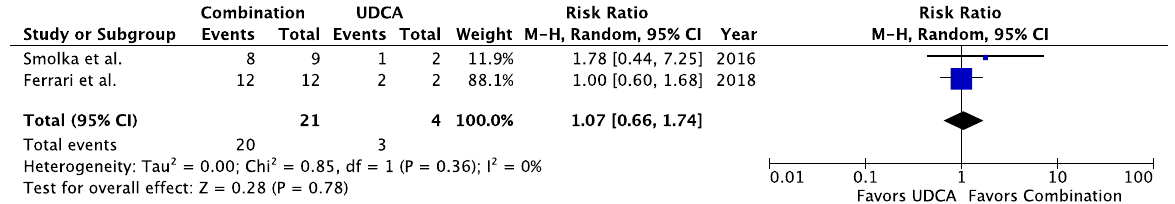
Figure 10. Biochemical improvement in ASC patients treated with combination therapy vs. UDCA. UDCA = ursodeoxycholic acid and Combination = UDCA + prednisone ± AZA.